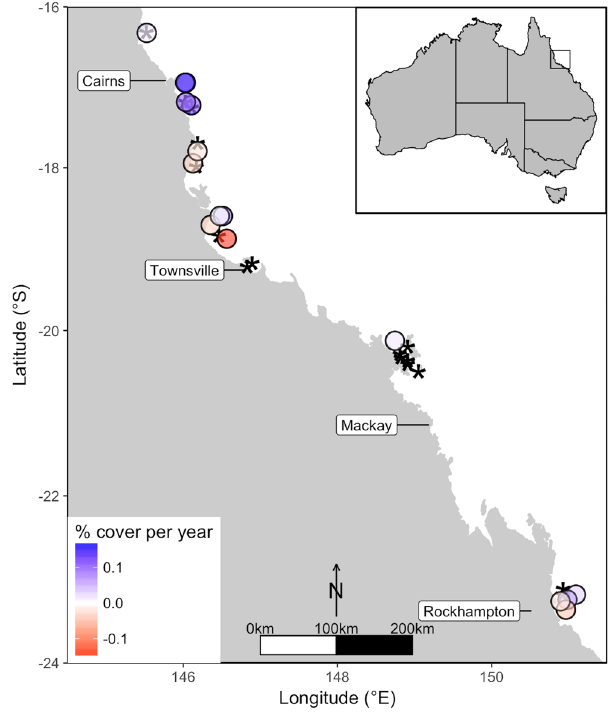
Figure 6. The spatial distribution of changes in C . orientalis cover on the inshore GBR. Circles represent locations where change over time was measured and an * represent locations where C . orientalis was absent (not detected in at least 3 survey years). Blue circles indicate increases in cover; white circles indicate zero change in cover; and red circles indicate decreases in cover. The map was created using R statistical software (version 3.3.1; https://www.r-project.org) and the packages “ggplot2” 69 , “mapdata” 70 , and “oz” 71